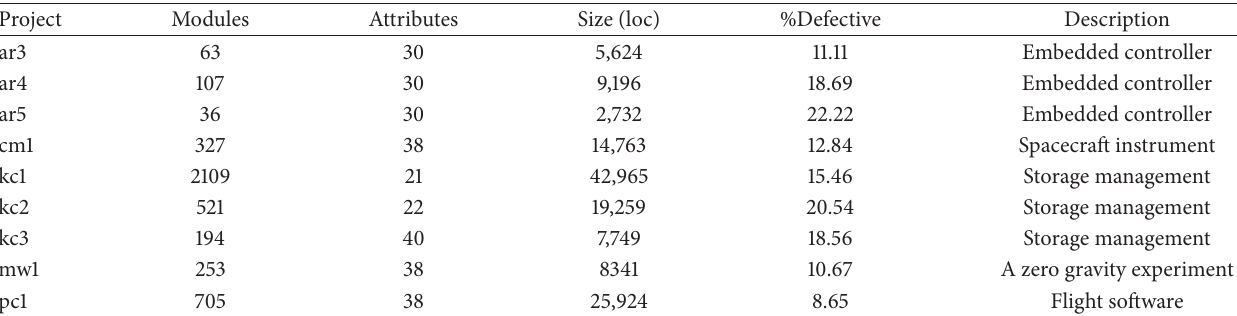
Table 1: Data sets.